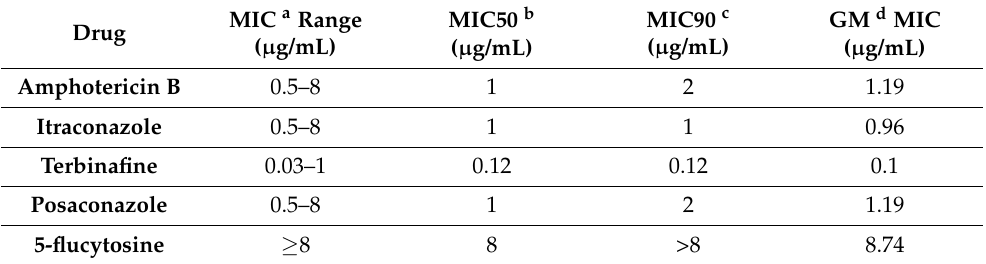
Table 2. Minimal Inhibitory Concentration of 46 Sporothrix brasiliensis isolates from 37 patients with severe sporotrichosis treated with amphotericin B at INI/FIOCRUZ between 1998 and 2018.